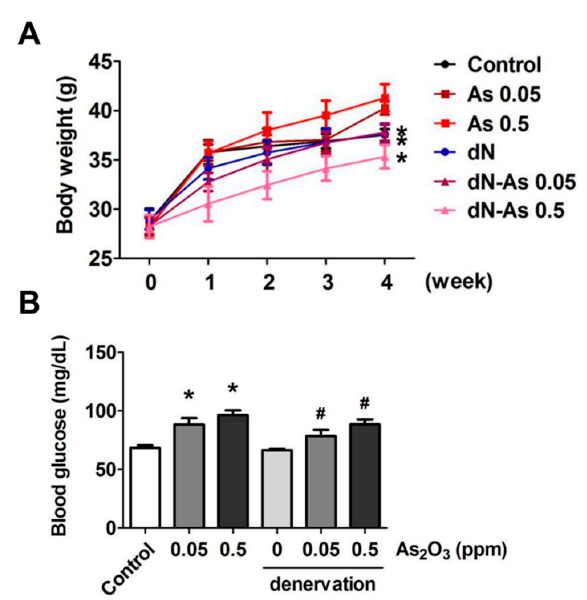
Figure 1. Effects of As 2 O 3 on the body weight and blood glucose in mice with or without denervation. As 2 O 3 (0.05 and 0.5 ppm) exposure from drinking water for 4 weeks in normal mice or denervated mice. ( A ). The changes in body weights were shown. ( B ). The blood glucose levels in mice were shown. Data are presented as the mean ± SEM ( n = 6 of each group). * P < 0.05 compared to the control group; # P < 0.05 compared to the denervation group.